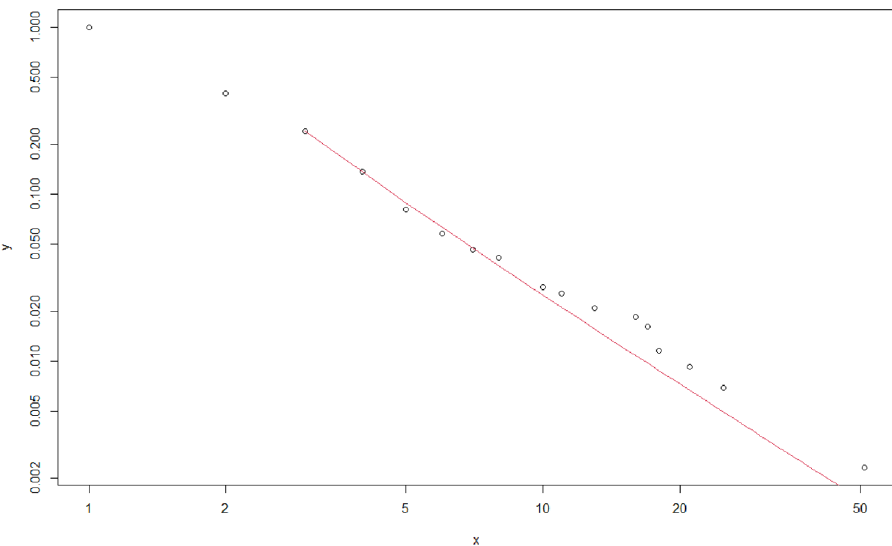
Figure 3. A log–log plot of out-degree. It is plotting the complementary cumulative distribution function of out-degree on doubly logarithmic axes. The red line presents the estimated power-law distribution.